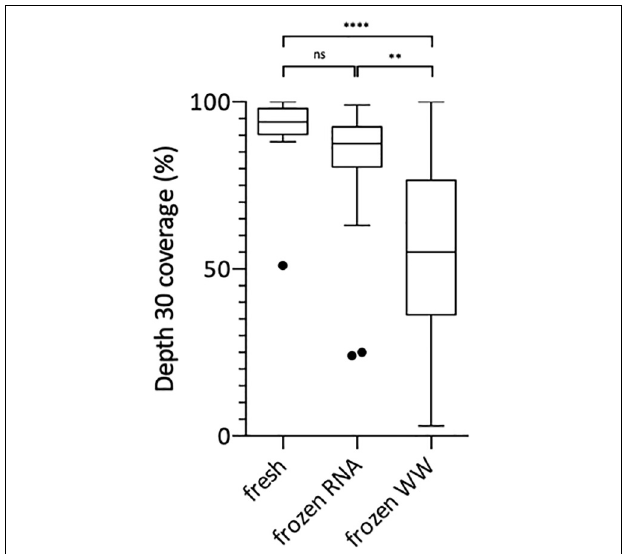
FIGURE 2 | Box Plot of SARS-CoV-2 genome coverage percentages obtained at depth 30 using the previously adapted method and starting from freshly prepared RNA, frozen RNA and frozen wastewater (WW). Kruskal-Wallis test followed by Dunn’s multiple comparisons test were used